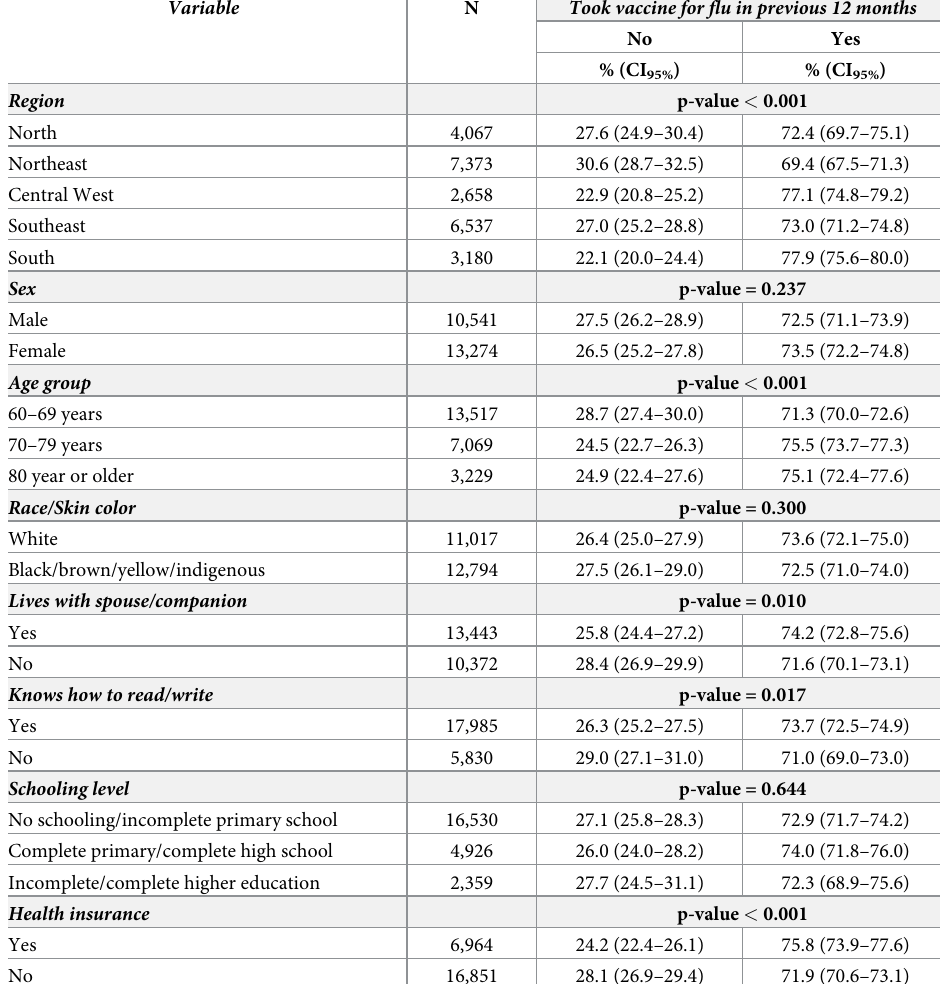
Table 1. Prevalence of non-vaccination and vaccination for influenza among Brazilian older people according to sociodemographic characteristics. National Health Survey, Brazil, 2013.